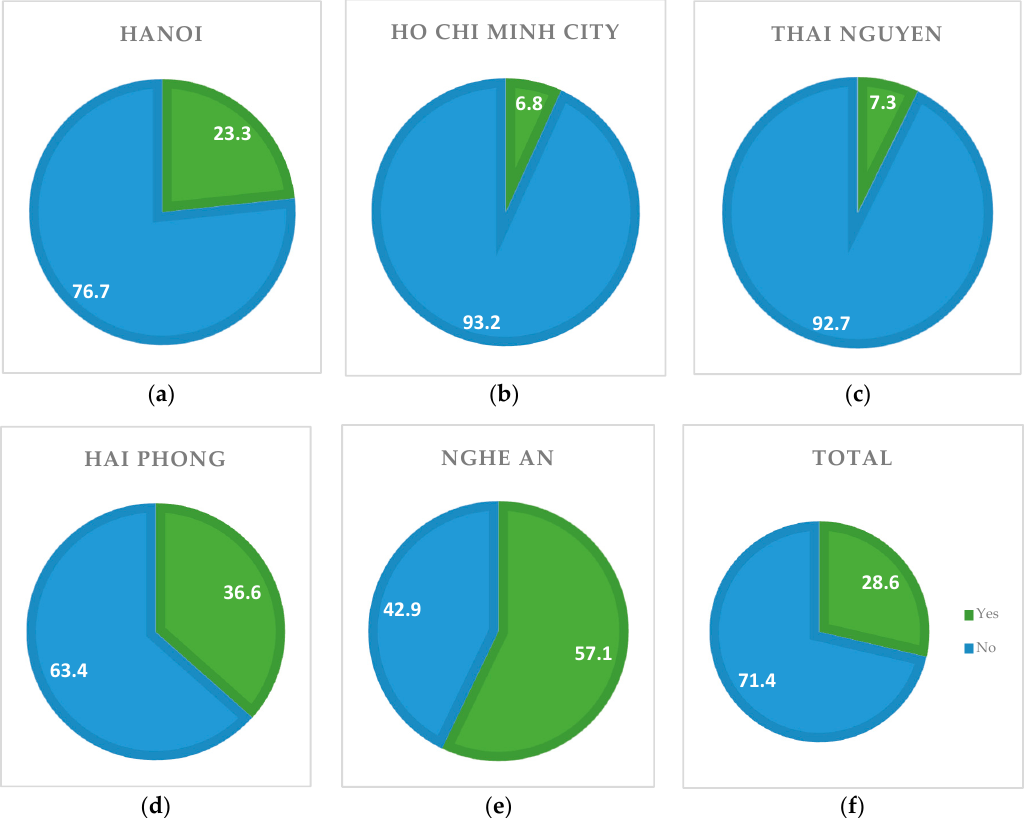
Figure 5. Sexual violence prevalence by localities (%). ( a ) Hanoi; ( b ) Ho Chi Minh City; ( c ) Thai Nguyen; ( d ) Hai Phong; ( e ) Nghe An; ( f ) Total.